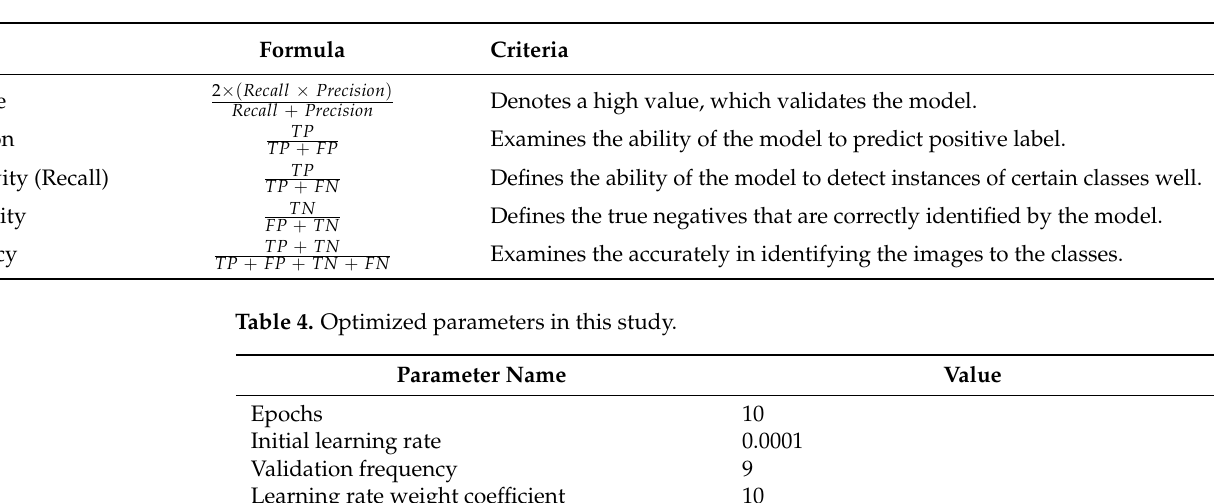
Table 3. Evaluation criteria.